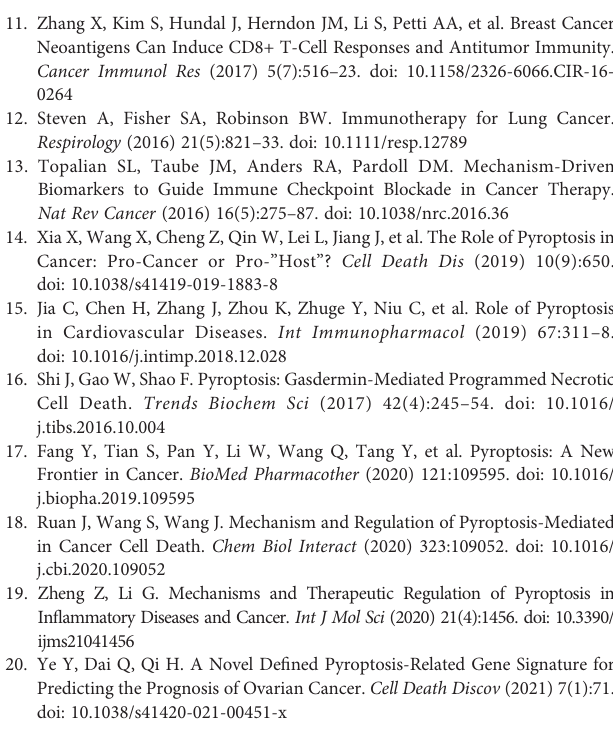
Supplementary Figure 1 | The expression levels of pyroptosis-related genes in CASP8 wild group and CASP8 mutant group. Supplementary Figure 2 | Prognostic analysis of pyroptosis-related genes in BRCA. Supplementary Figure 3 | Unsupervised clustering identi fi es three different Pyroptosis clusters. (A) Consensus clustering matrix for k = 3. (B) Consensus clustering cumulative distribution function (CDF) for k = 2 – 10. (C) Relative change in the area under CDF curve for k = 2 – 9. (D) Distribution of each sample in different clusters when k ranges from 2 to 9. Supplementary Figure 4 | Unsupervised clustering identi fi es three different geneCluster. (A) Consensus clustering matrix for k = 3. (B) Consensus clustering cumulative distribution function (CDF) for k = 2 – 10. (C) Relative change in the area under CDF curve for k = 2 – 9. (D) Distribution of each sample in different clusters when k ranges from 2 to